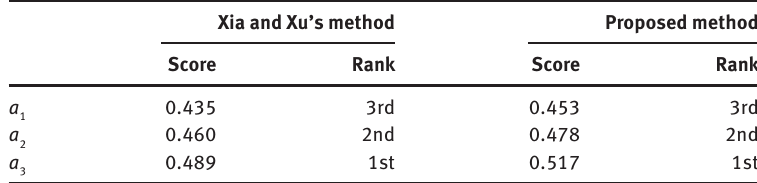
Table 12: Comparisons of the Scores and